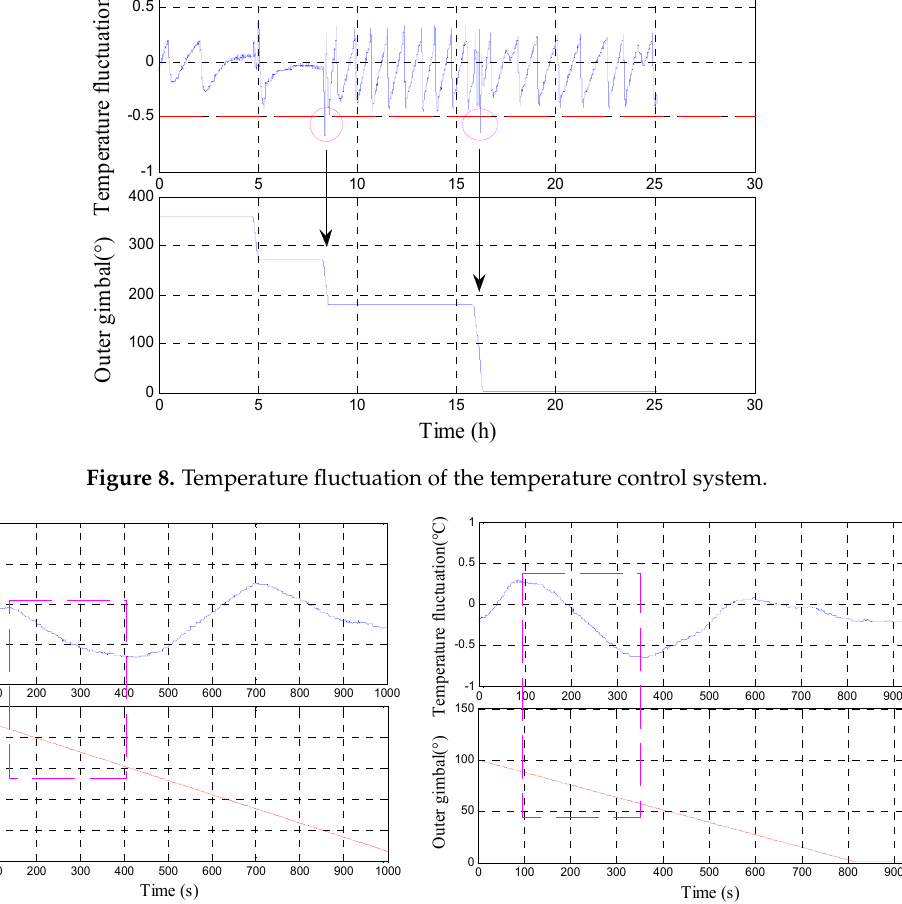
Figure 9. Temperature fluctuation of the temperature control system in the gimbal angle ranges of ( a ) 270–246° and ( b ) 92–54°.